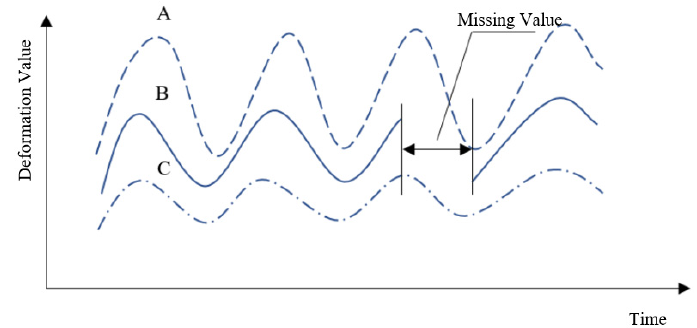
Figure 2. Schematic diagram of partial sequence deletion.